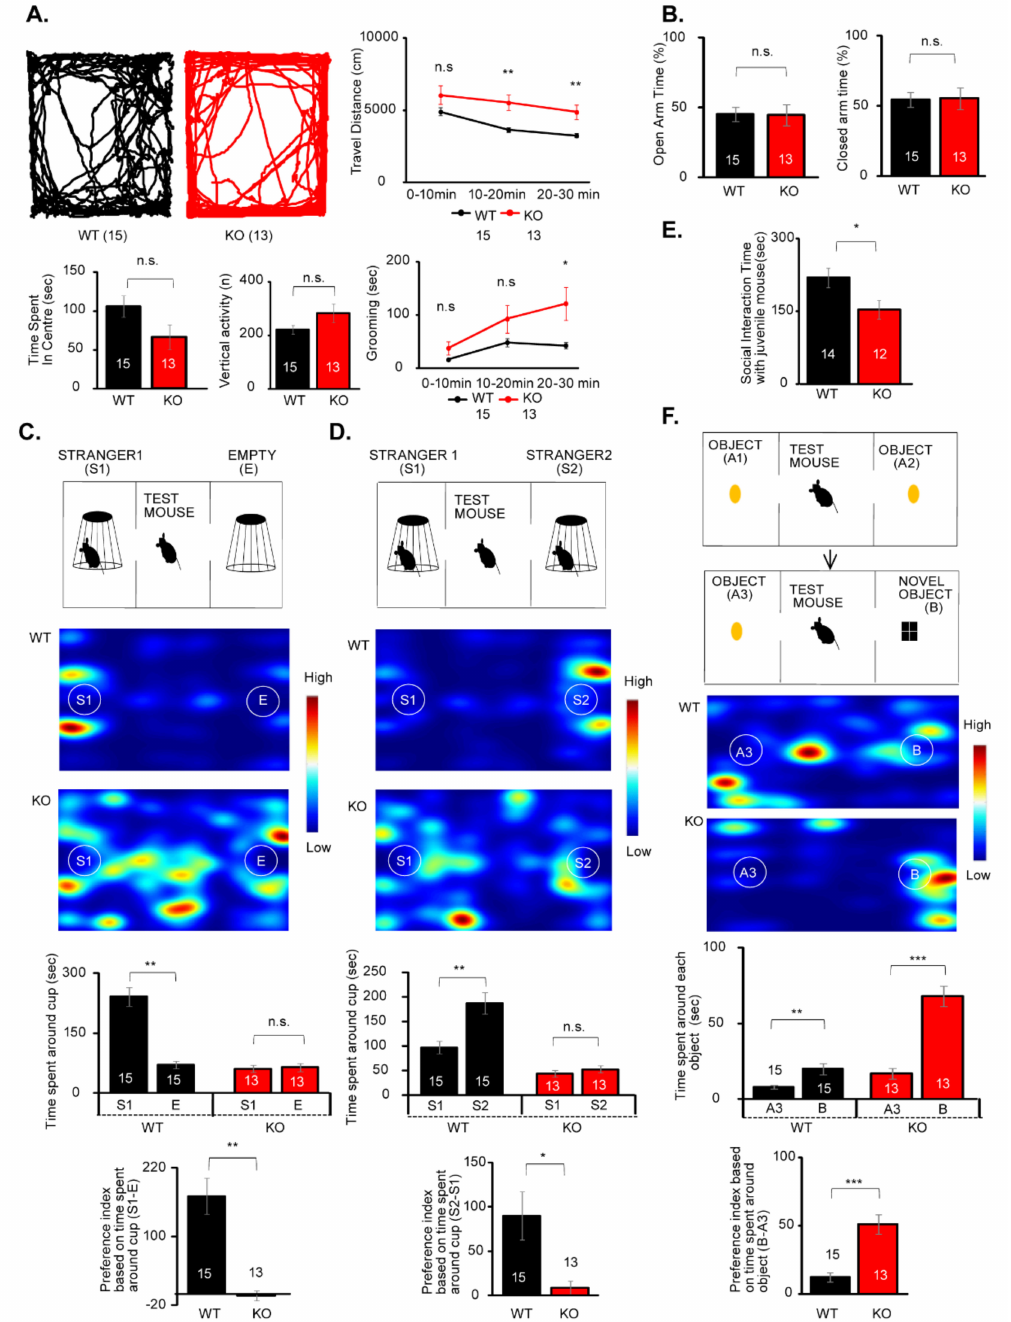
Figure 1. IQSEC2 KO mice display hyperactivity, overgrooming, impaired social and social novelty preference, and enhanced novel object preference. ( A ) Trajectories of movement and summary graphs for travel distance, time spent in center, vertical activity, and grooming in the open field test. Travel distance and grooming time are increased in IQSEC2 KO mice. ( B ) Summary graphs for elevated plus maze test. No changes were detected in time spent in open and closed arms between wild-type and IQSEC2 KO mice. ( C ) Experimental diagram (top), heatmap images (middle), and summary graphs (bottom) for social preference test using three-chamber apparatus. Preference for a stranger mouse (S1) to an